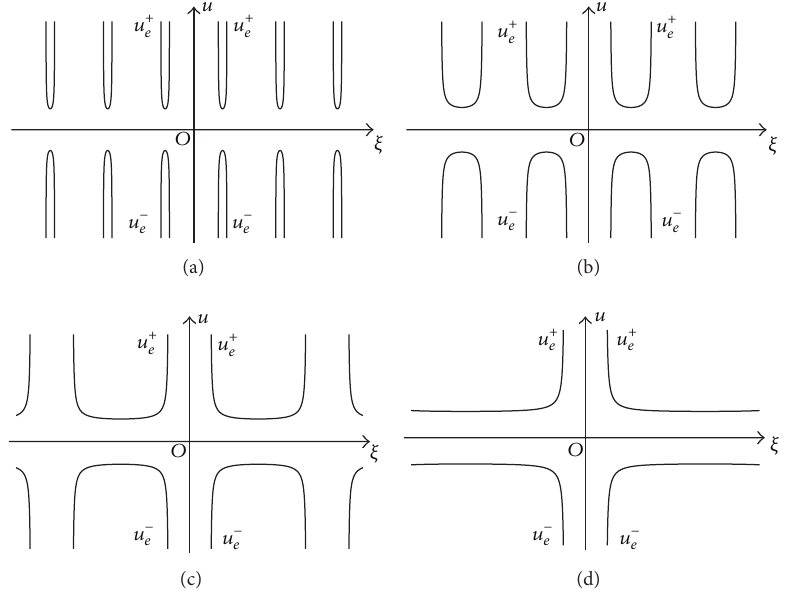
Figure 8: The 1-blow-up waves are bifurcated from the periodic-blow-up waves. The varying process for the figures of 𝑢 ± 𝑒 when 𝑏 → −(5𝑎 2 /36𝑐) + 0 , where 𝛾 = 𝛿 = 𝑐 = 𝑎 = 1 and (a) 𝑏 = −(5𝑎 2 /36𝑐) + 10 −1 , (b) 𝑏 = −(5𝑎 2 /36𝑐) + 10 −2 , (c) 𝑏 = −(5𝑎 2 /36𝑐) + 10 −3 , and (d) 𝑏 = −(5𝑎 2 /36𝑐) + 10 −4